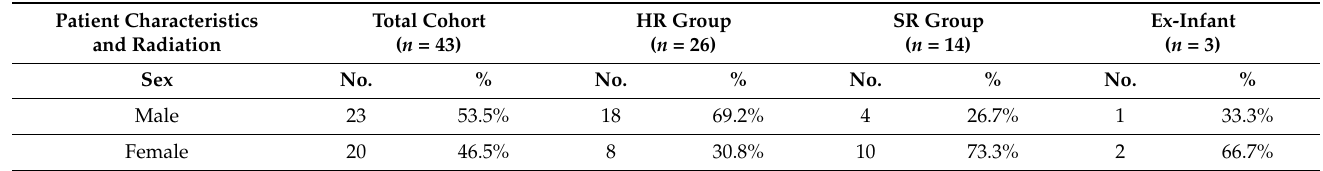
Table 1. Demographic characteristics, pathology, staging, and radiation doses. Patient Characteristics and